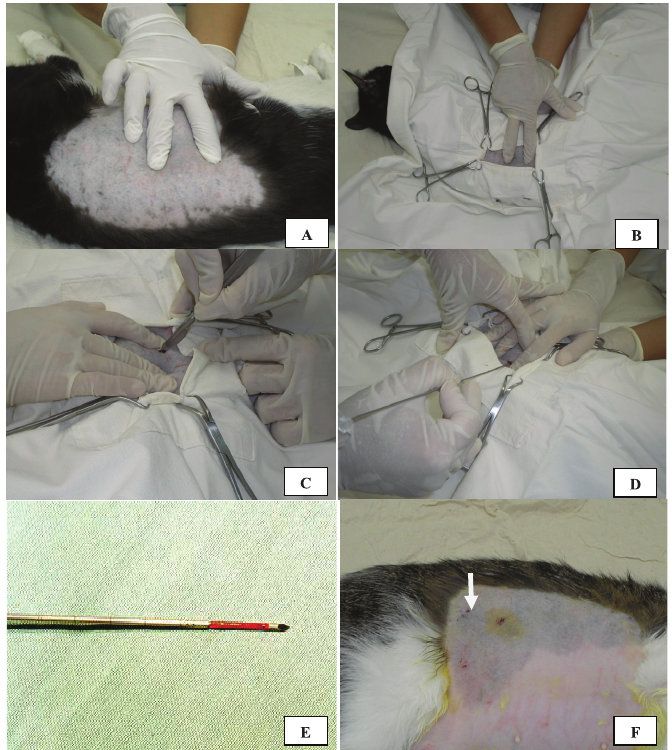
FIGURE 1 - A ) Palpation of the abdominal cavity for localization and immobilization of the biopsied kidney; B ) Immobilization of the kidney by the assistant using the index and middle fingers located in the cranial and caudal poles of the kidney; C ) Small incision of the skin; D ) Fixation of the kidney in its ventral face for later needle incision in its caudal pole by the needle operator; E ) A core of renal tissue present in the exposed internal cannula of Tru-Cut needle; F ) Surgical wound after the